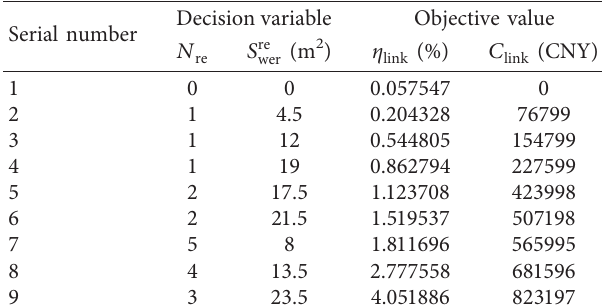
Figure 6: The Pareto front obtained by link planning 6. Table 3: The Pareto solution of link planning